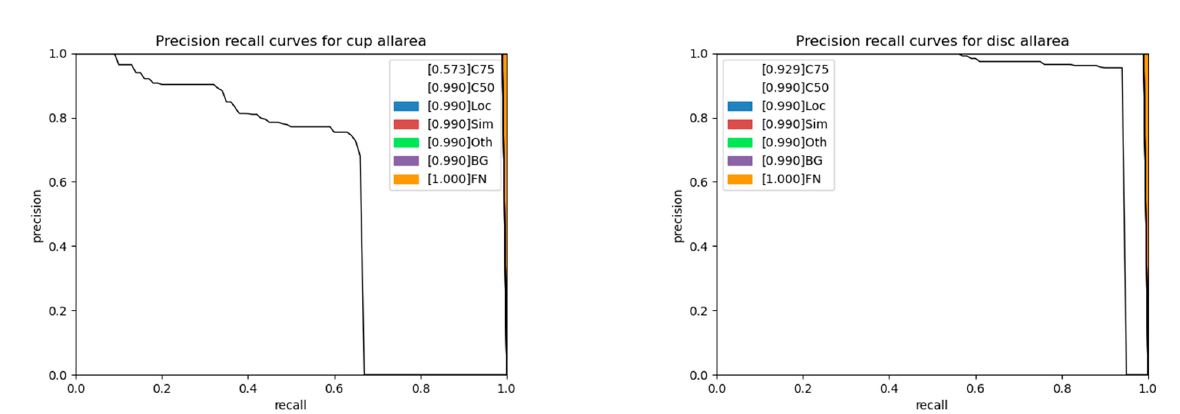
Figure 7. Precision-recall curves for each model on G1020 dataset. F1 score is provided for each model.